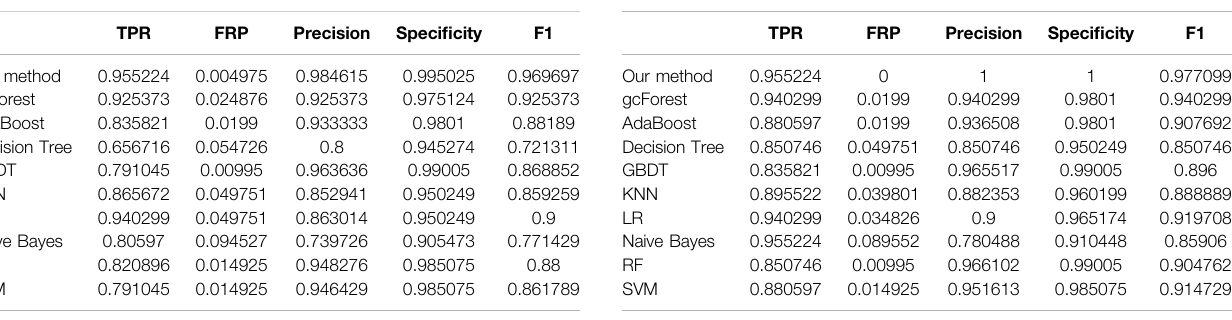
TABLE 6 | Classi fi cation performances of ten methods with 15-cross validation